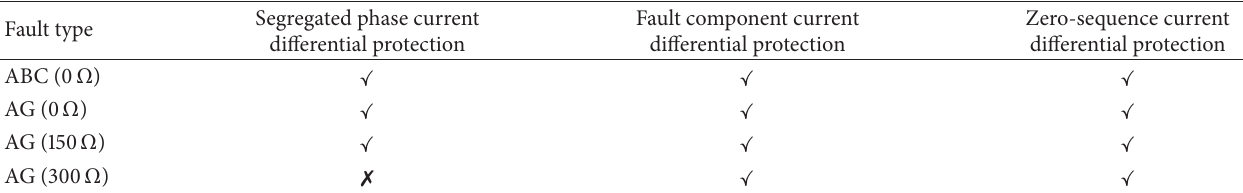
Table 2: Operation of current differential protection when the different fault occurred at the fault point F1.